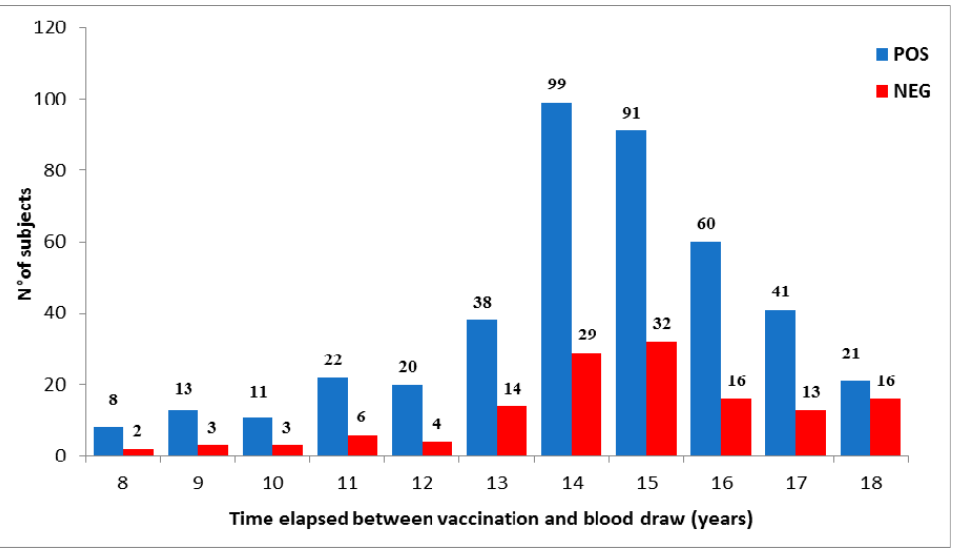
Figure 3. Seroprevalence of measles antibodies after vaccination over-time. Antibody response in vaccinees was analyzed 8–18 years after complete vaccination. The number of seropositive and seronegative subjects was plotted.